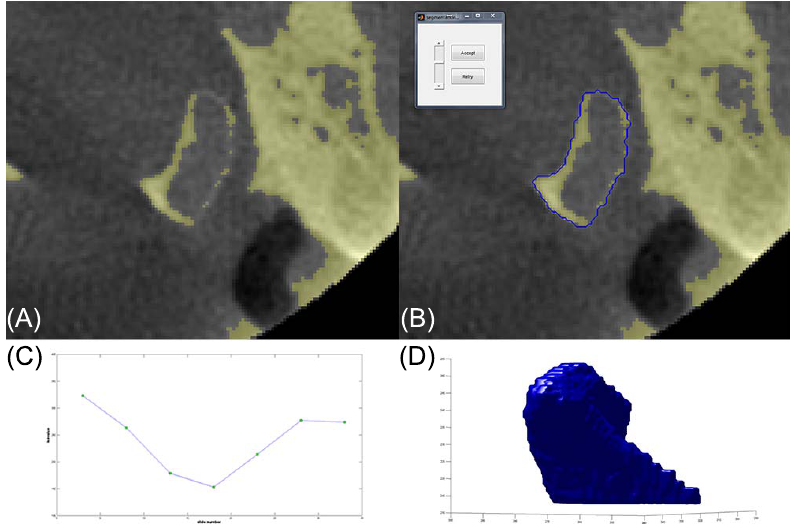
Figure 2. Schematic overview of the segmentation algorithm. The faulty outline of the thresholded condyle is clearly present (A). The user selects a seed-point once every five slides. The selection of this seed point automatically renders an outline of the condyle based on the threshold (B). The user can adjust the threshold interactively to generate the best fit for the condylar outline. All threshold values are plotted in a graph (C). For all slides in between the two user defined slides, the threshold value is determined through interpolation. Subsequently, the region growing is initiated, after which post processing is possible. Finally, the condyle is segmented and rendered in 3D (D).